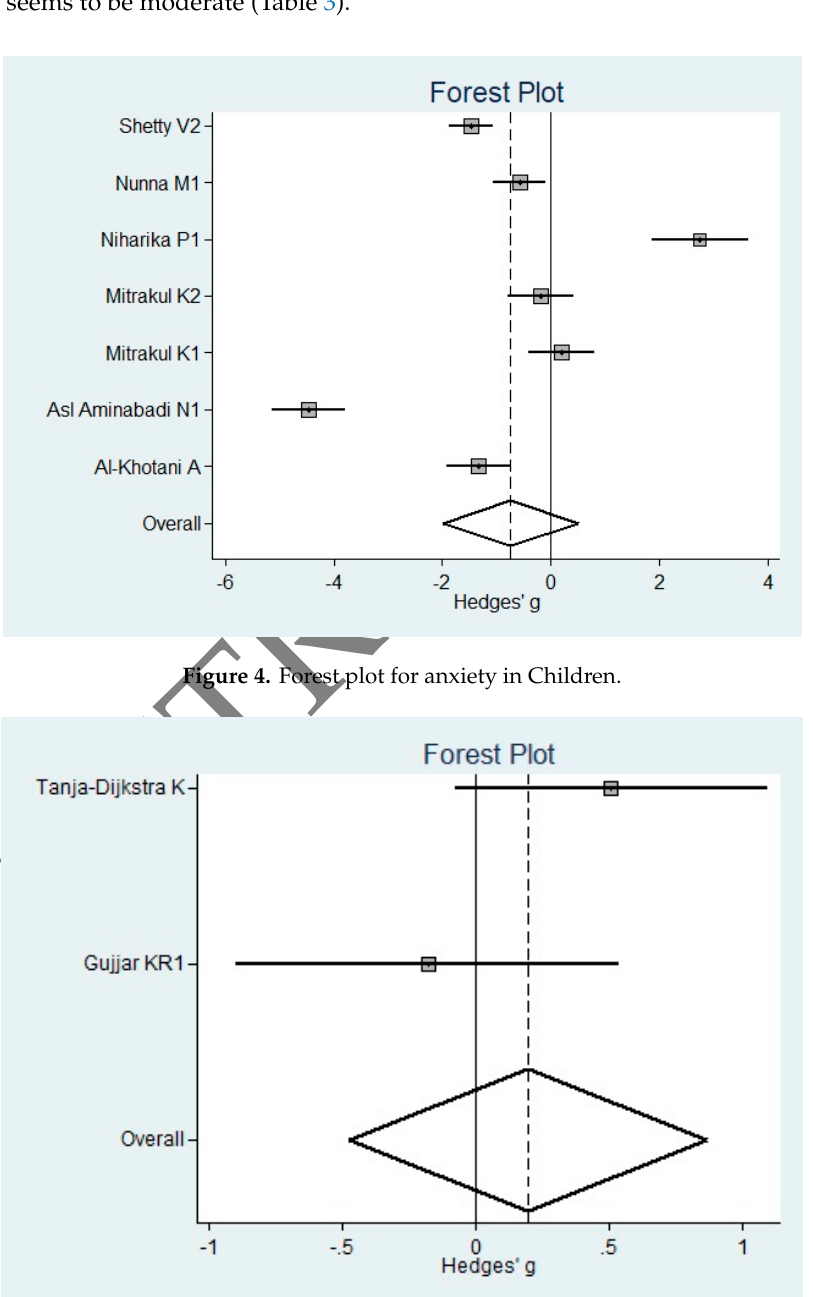
Figure 5. Forest plot for Anxiety in Adults.